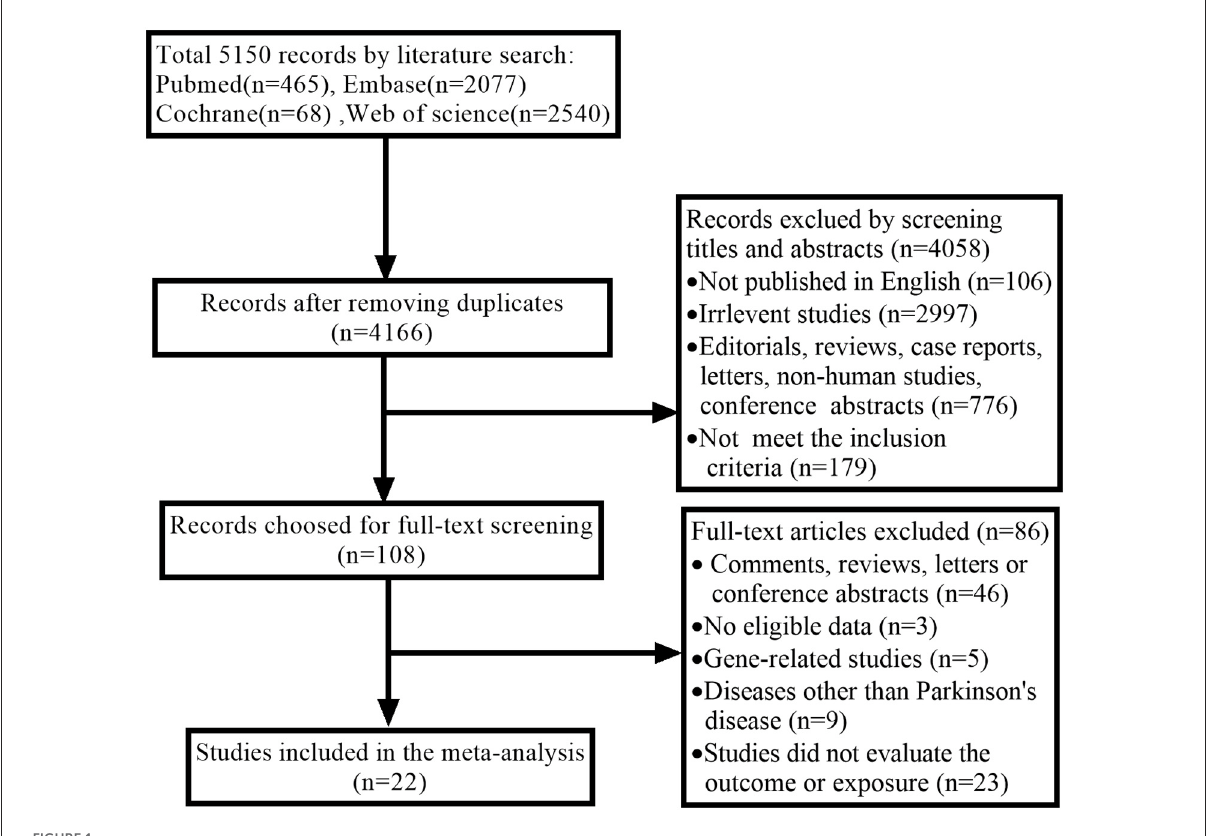
FIGURE1 Flowchart of the study